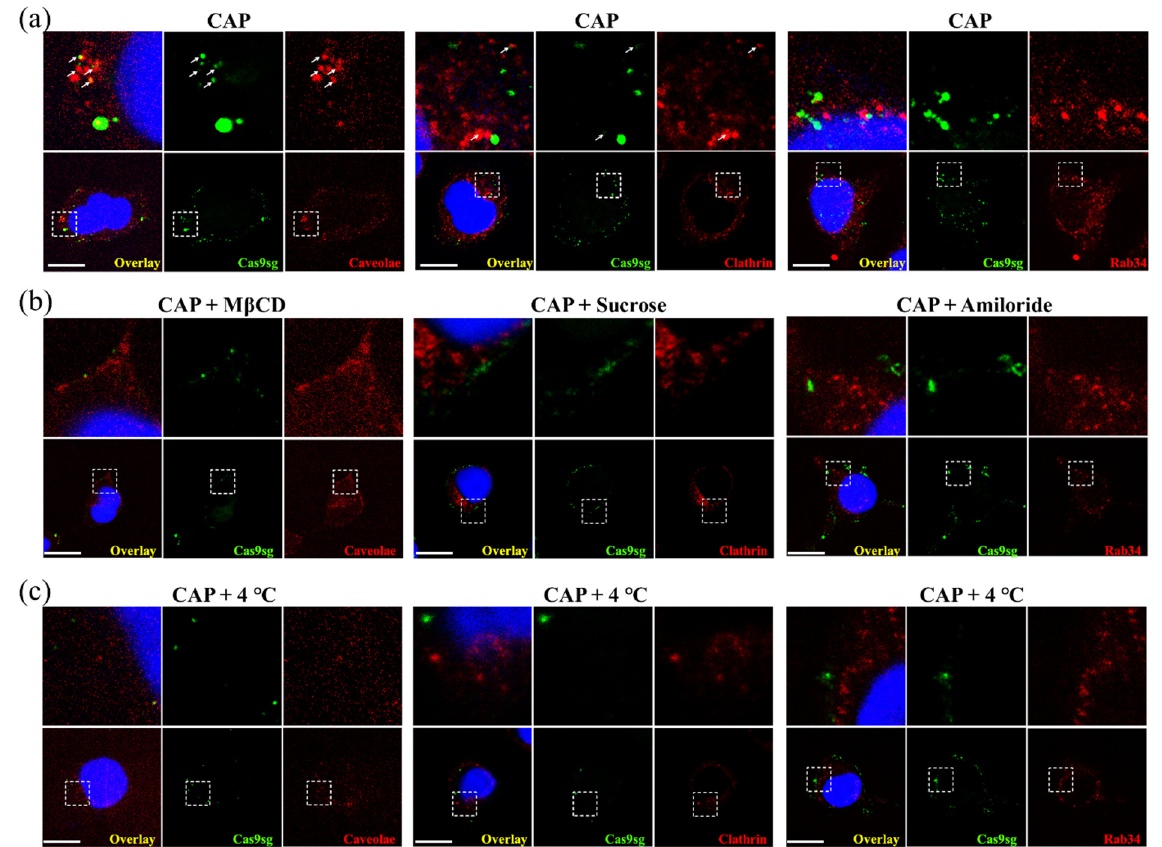
Figure 4. CAP-mediated cellular uptake of Cas9sg monitored by direct immunofluorescence: ( a ) Confocal images of CAP-treated cells incubated Cas9sg (green) for 4 h, and then the immunofluorescence experiments were performed to detect Caveolae, Clathrin-mediated endocytosis, and the macropinocytosis (red) with the primary antibody, respectively, against Caveolae, Clathrin, and Rab34; ( b ) Confocal immunofluorescence images of CAP-treated cells incubated Cas9 in presence of endocytosis inhibitors M β CD, Sucrose, and Amiloride, respectively; ( c ) Confocal immunofluorescence images of CAP-treated cells incubated Cas9 at a low temperature of 4 °C (C Cas9sg = 8 nmol L − 1 ).